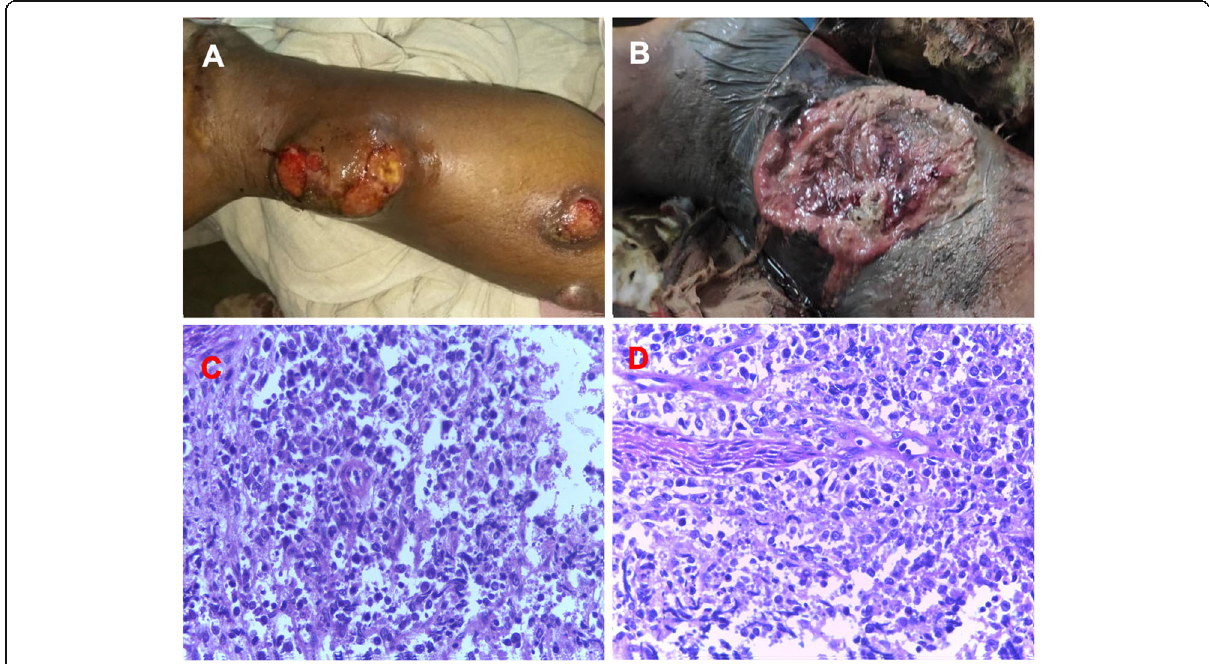
Fig. 1 Cutaneous manifestations and histology of primary cutaneous diffuse large B cell lymphoma; a ulceroproliferative growth over the leg progressing to b gangrenous lesion; c , d H&E stained slides from the lesion showing diffuse infiltration by large atypical lymphoid cells with abundant cytoplasm